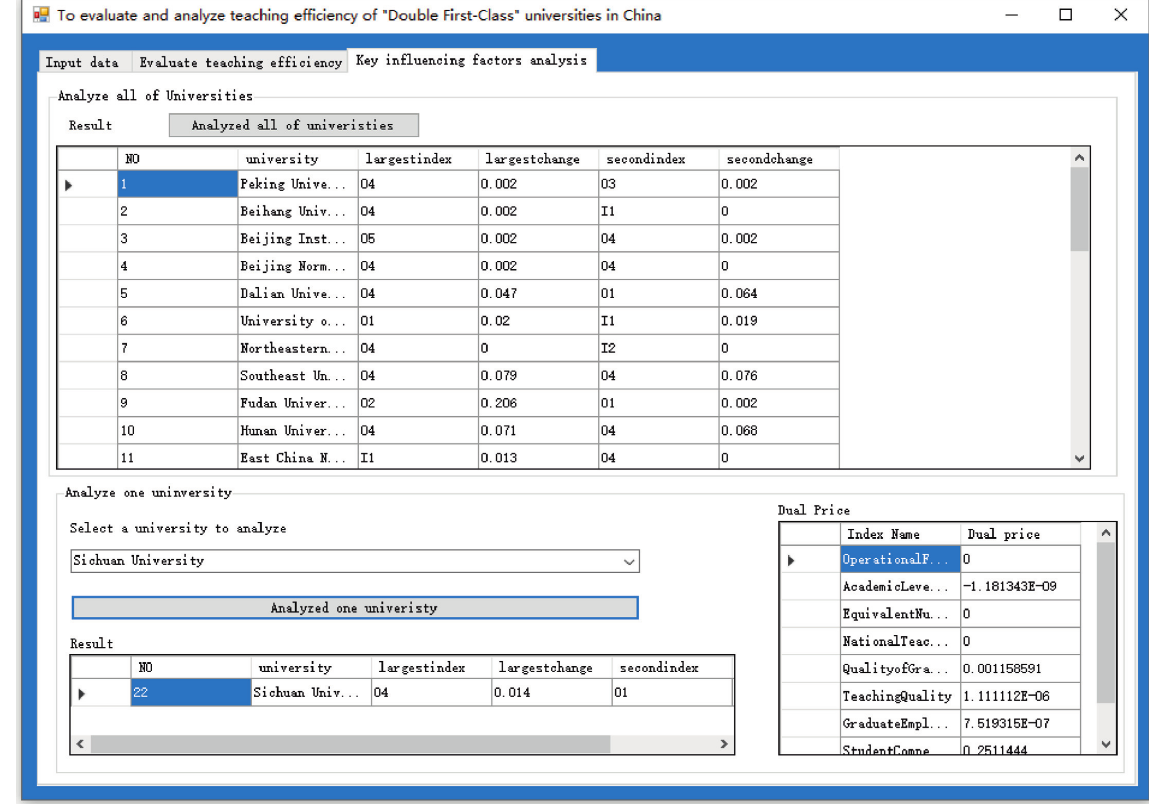
Figure 4: Interface for the key influencing factors